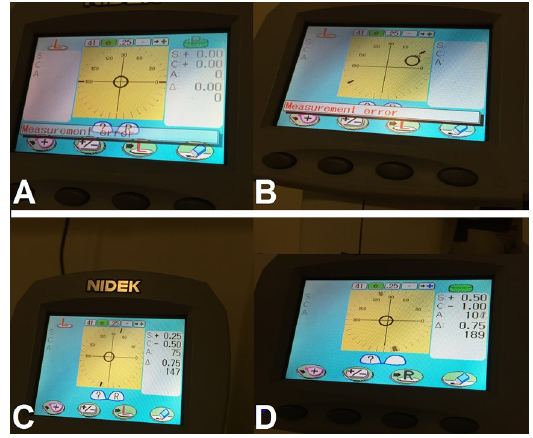
Figure 7. Measuring the membranes with the focimeter, M1 (a), M2 (b), M3 (c) e M4 (d). In the images, the angle of the